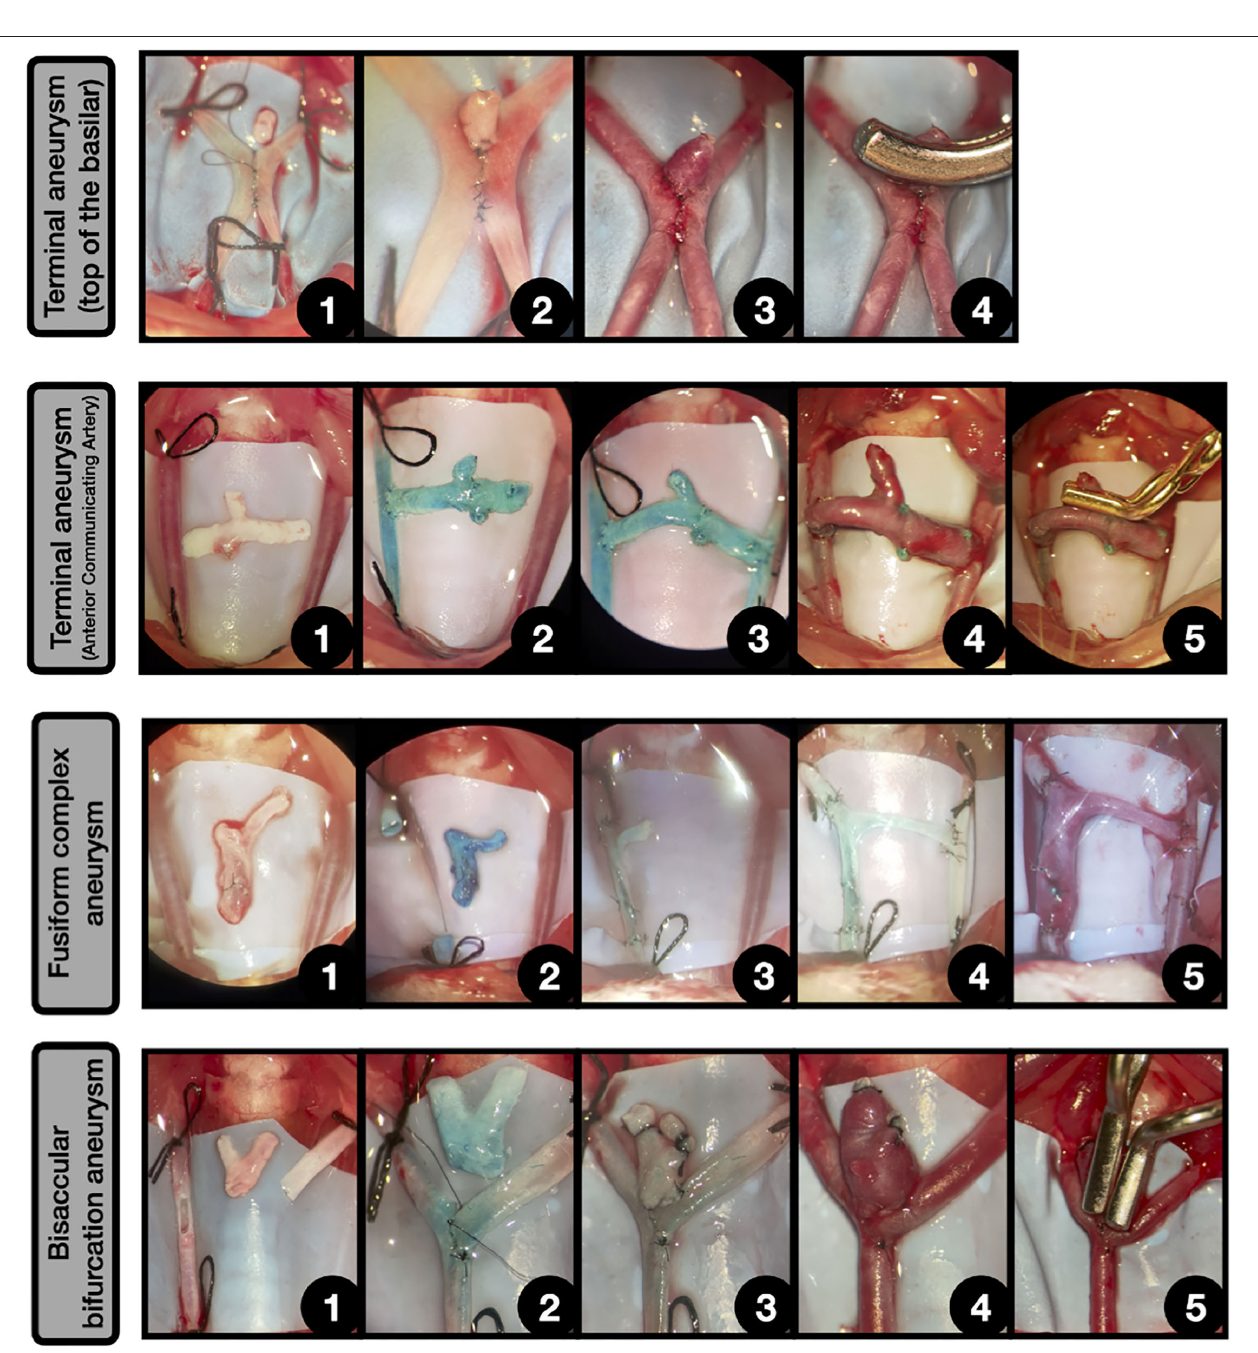
FIGURE 11 | Other complex aneurysms. Terminal aneurysm (Top of the basilar) [4]: 1: Side-to-side anastomosis between both CCAs, leaving a hole in the top. Above lies a free venous graft; 2: The graft is sutured to the hole and the free edge is occluded; 3: After declamping the aneurysm enlarged on the top of the anastomosis, simulating a terminal aneurysm placed on the top of the construction; 4: The aneurysm is clipped. Terminal aneurysm (Anterior communicating artery) [4]: 1: Both CCAs are exposed and ligated and a free graft from jugular vein bifurcation is obtained; 2: The graft is anastomosed in an end-to-side fashion to the right CCA; 3: Another end-to-side anastomosis between the graft and the contralateral CCA is performed, obtaining a connection between both CCAs. The remaining above free lumen is occluded by suture; 4: After releasing the ligatures a terminal aneurysm that arises from the venous graft is obtained, simulating the circuitry of an anterior communicating artery; 5: The aneurysm is clipped. Fusiform complex aneurysm [4]: 1: Both CCAs are exposed and ligated and a free graft from jugular vein bifurcation is obtained; 2: A straight arteriotomy is made in right CCA and the free venous graft is dyed in blue; 3: The graft is anastomosed in an end-to-end fashion to both CCAs free lumens, leaving a branch oriented to the contralateral CCA; 4: The branch is anastomosed to the contralateral CCA in an end-to-side fashion; 5: After the declamping, the venous segment enlarges, obtaining a complex fusiform